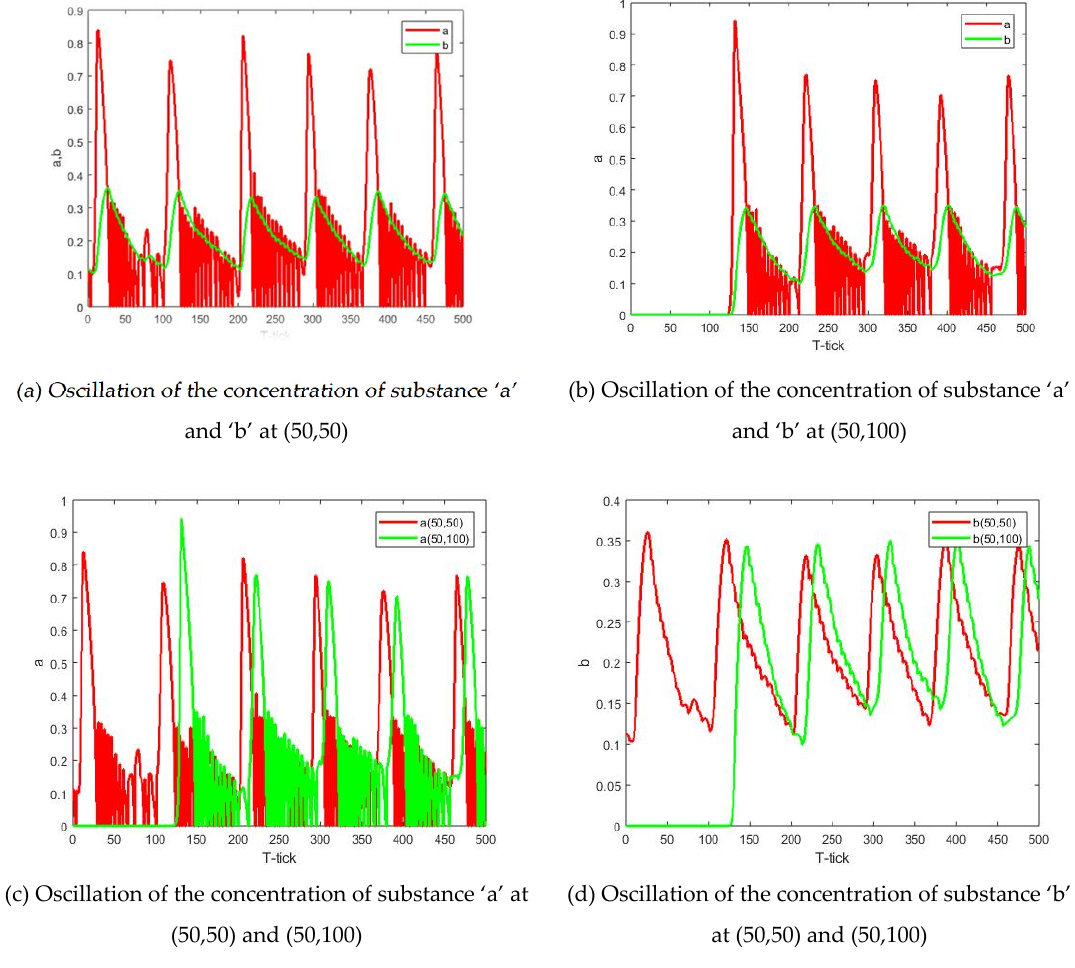
Figure 7. The concentration changes of ‘ a’ and ‘ b’ with time at point (50,50) and (50,100).